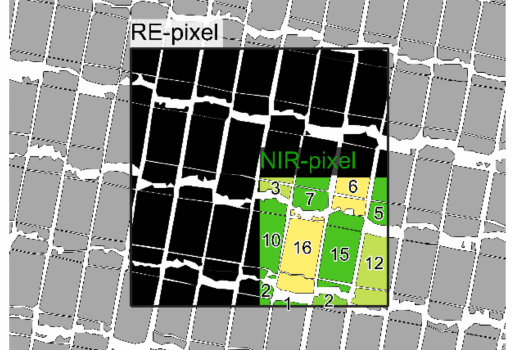
Figure 2. Section of a plot-shapefile with an exemplarily indicated NIR- and Red Edge (RE)-grid element. For the NIR-pixel, the percentage area shares of the different plots for the generation of the yield map are